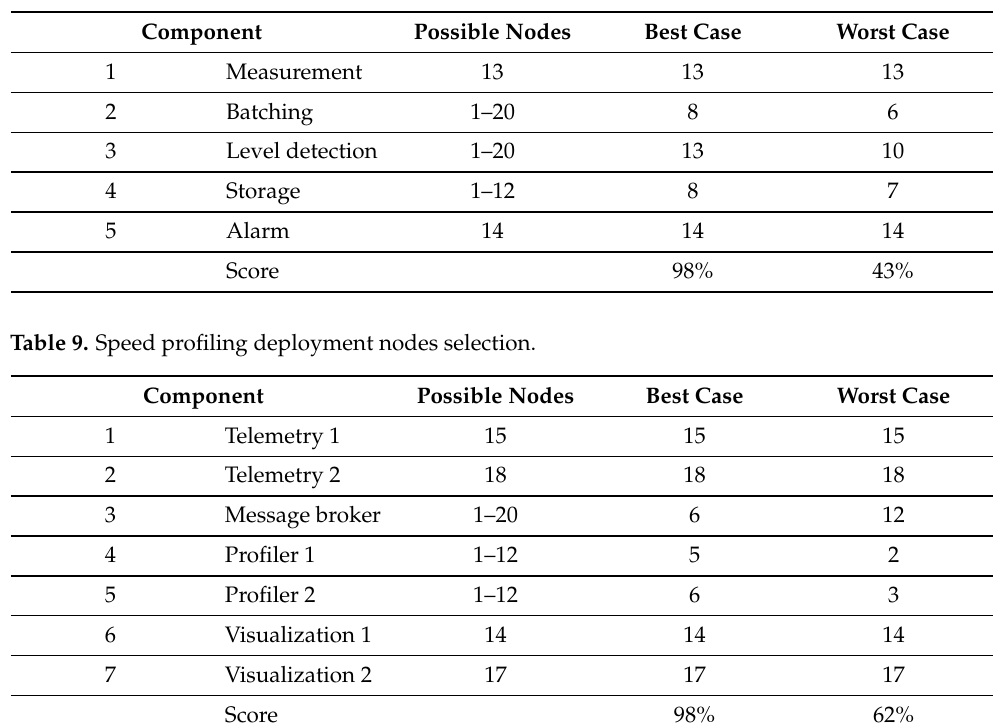
Table 8. Smoke monitoring deployment nodes selection.